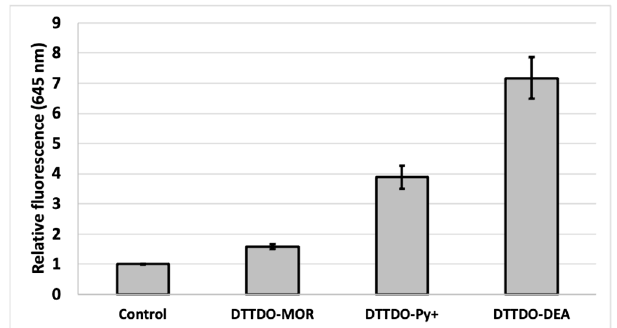
Figure 7. The intensity of fluorescence in A431 cells after 1 h treatment with DTTDO derivatives. Results represent the mean fluorescent value at λ em = 645/40 nm with λ ex = 530/25 nm calculated to control cells (cells treated with DMSO). Compounds concentration 10 µM.